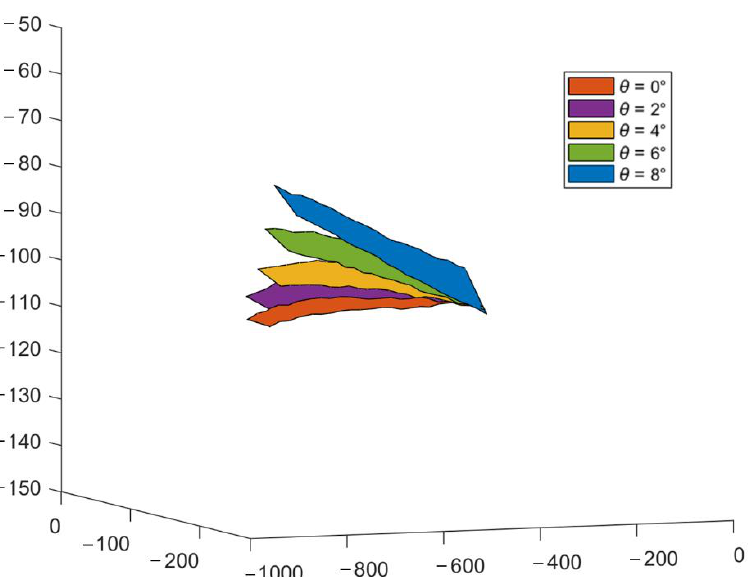
Figure 11. The 3D reconstruction results of the rotor blade measured at the same azimuth location with five different collective pitch angles in hover flight.